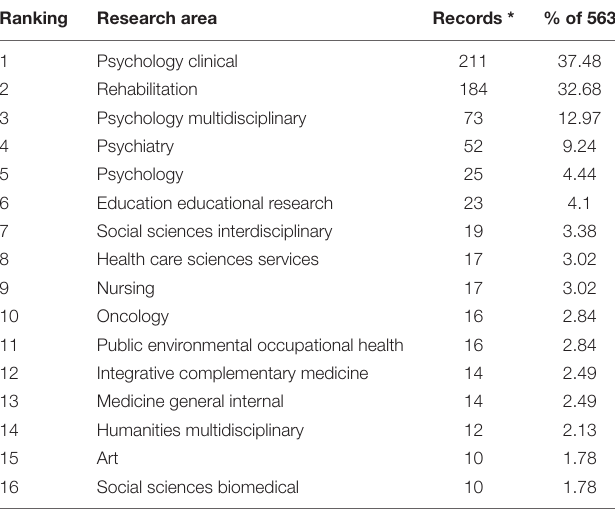
TABLE 6 | Publications in art therapy, by research